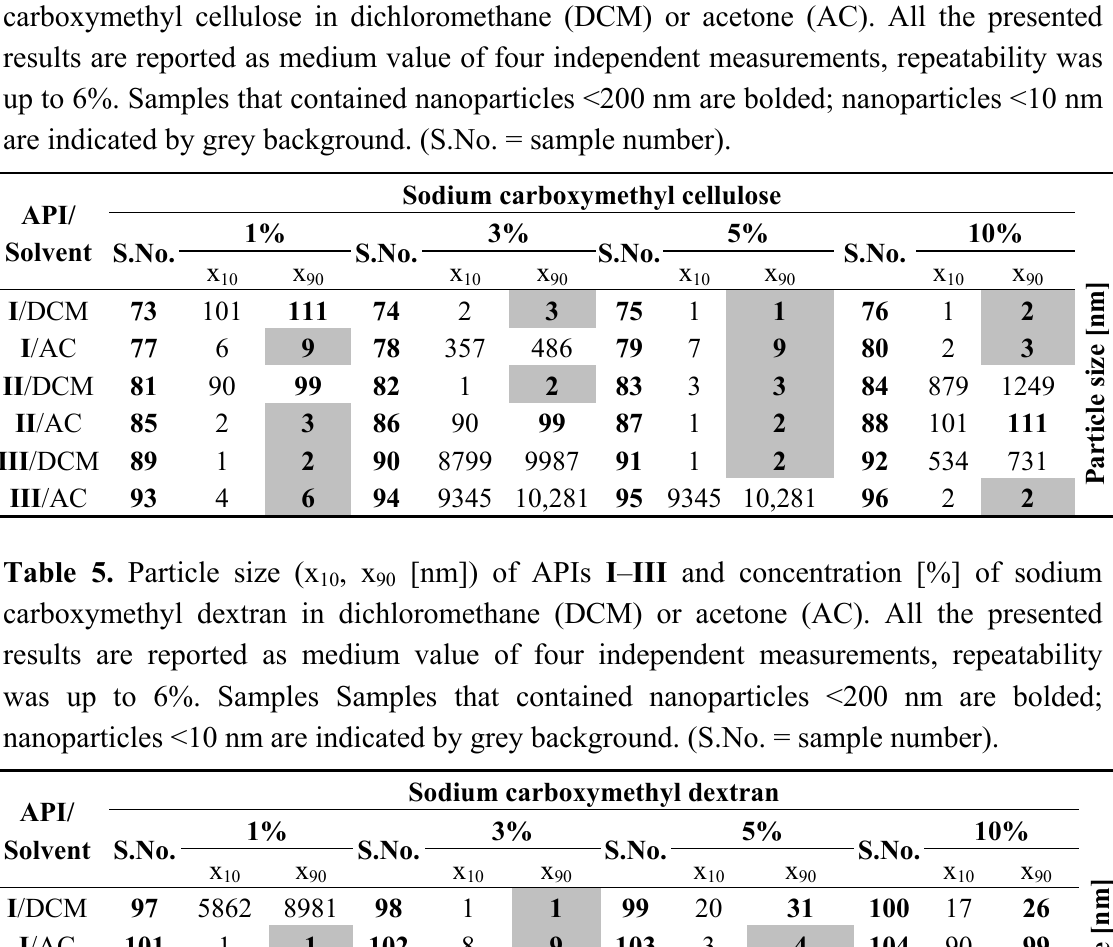
Table 4. Particle size (x , x [nm]) of APIs I – III and concentration [%] of sodium 10 90 carboxymethyl cellulose in dichloromethane (DCM) or acetone (AC). All the presented